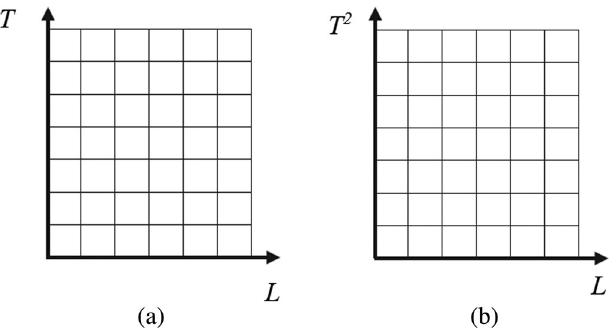
FIG. 6. (a) L − T and (b) L − T 2